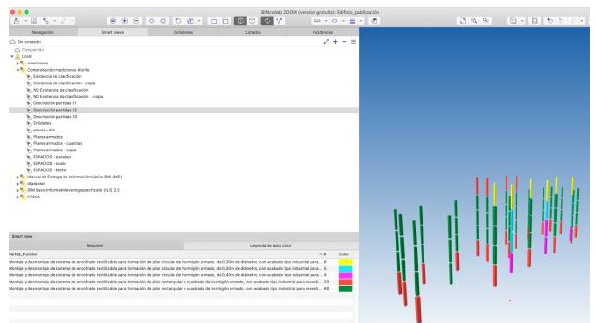
Figure 8. Review of the IFC file in BIMcollab ZOOM. Colours define types of column formwork